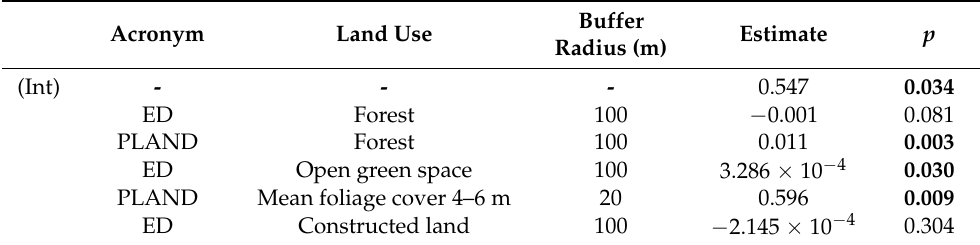
Table 5. Results of model averaging for bird species FDis for the top models (Table 4). The definitions of predictors are listed in Table 1. p values < 0.05 are in bold